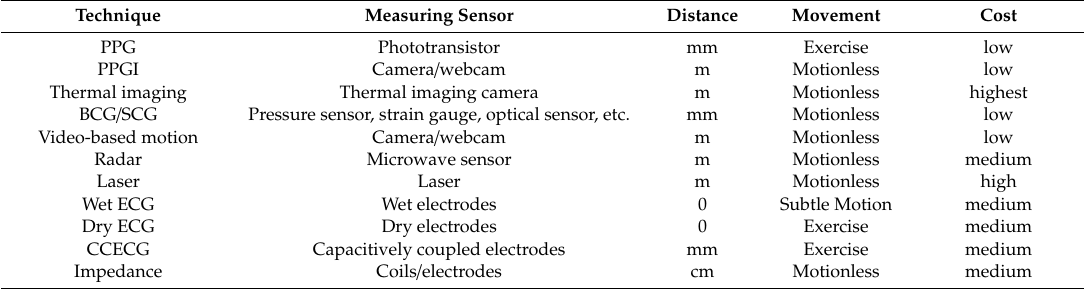
Table 11. Comparison of di ff erent HR monitoring